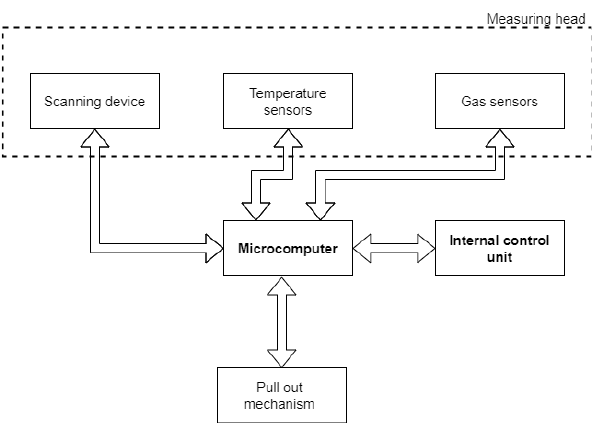
Figure 13. Simple diagram of Sensors Unit